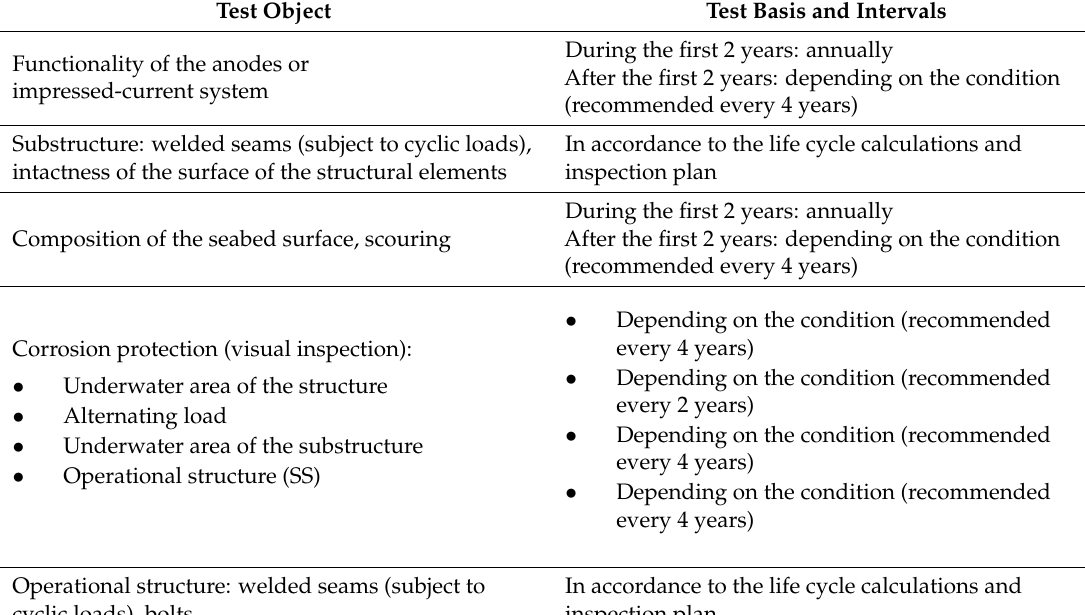
Table 3. Minimum requirements for the periodic inspection of SS according to the BSH